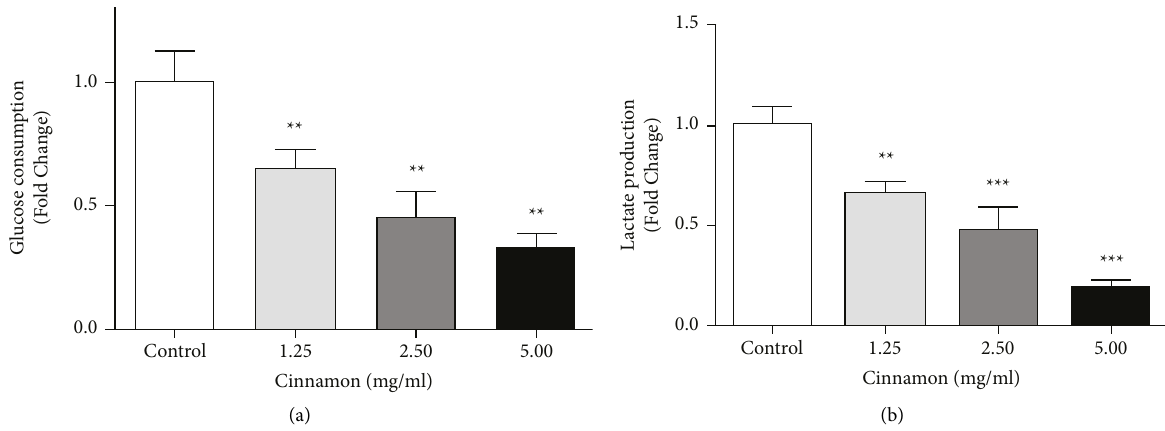
Figure 6: Effect of different concentrations of Cinnamon aqueous extract on glucose consumption (a) and lactate production (b) in 5637 cells. Data are represented as the mean ± SD. All value is the average of at least three independent replicates. ( ∗∗ P < 0 . 01 and ∗∗∗ P < 0 . 001 compared to the control